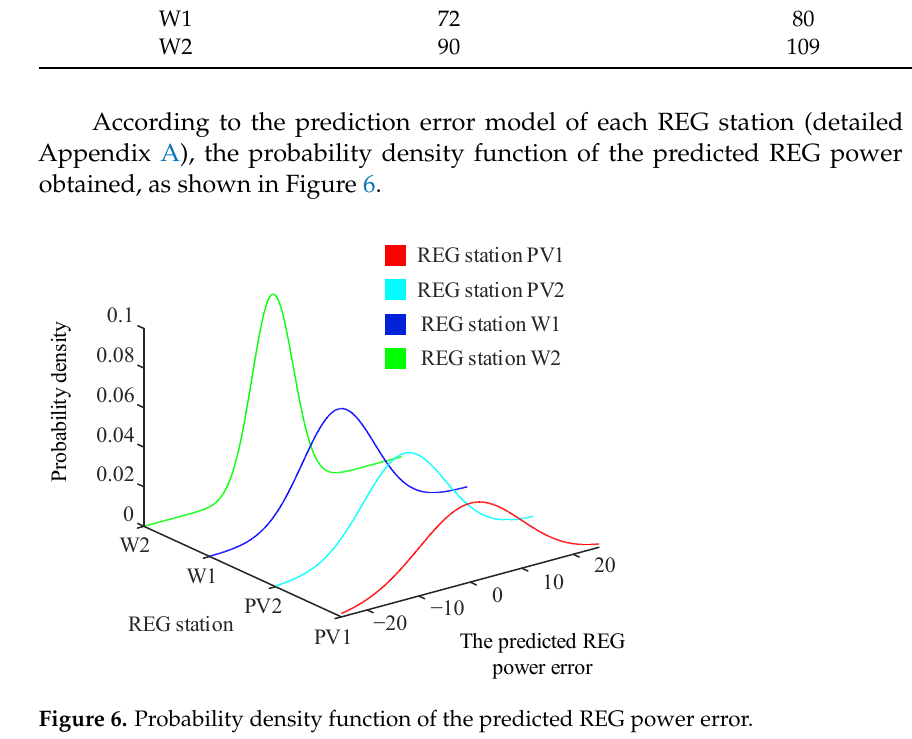
Figure 5. A 220 kV power grid system with a new REG cluster. Table 2. Actual power output of each REG station/MW. Lf P . j t